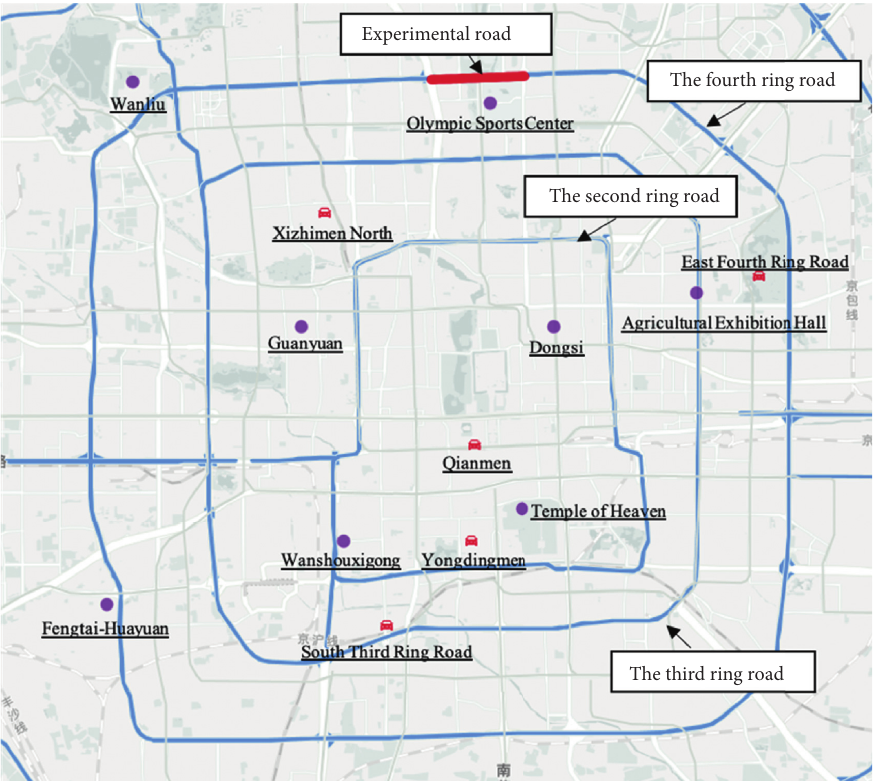
Figure 4: Distribution of monitoring sites in the Fifth Ring Road of Beijing. Table 2: Classification of air quality monitoring sites in Beijing.